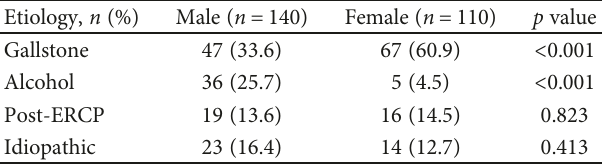
Table 2: Etiology of acute pancreatitis according to the gender.